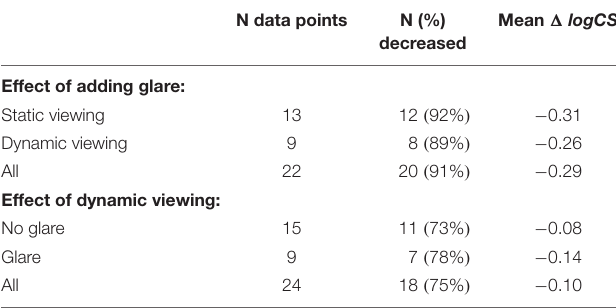
FIGURE 4 | Correlations between CS measured in and out of the simulator. Dashed lines show geometric mean regression slopes. TABLE 1 | Simple main effects of glare or motion on contrast sensitivity (CS).